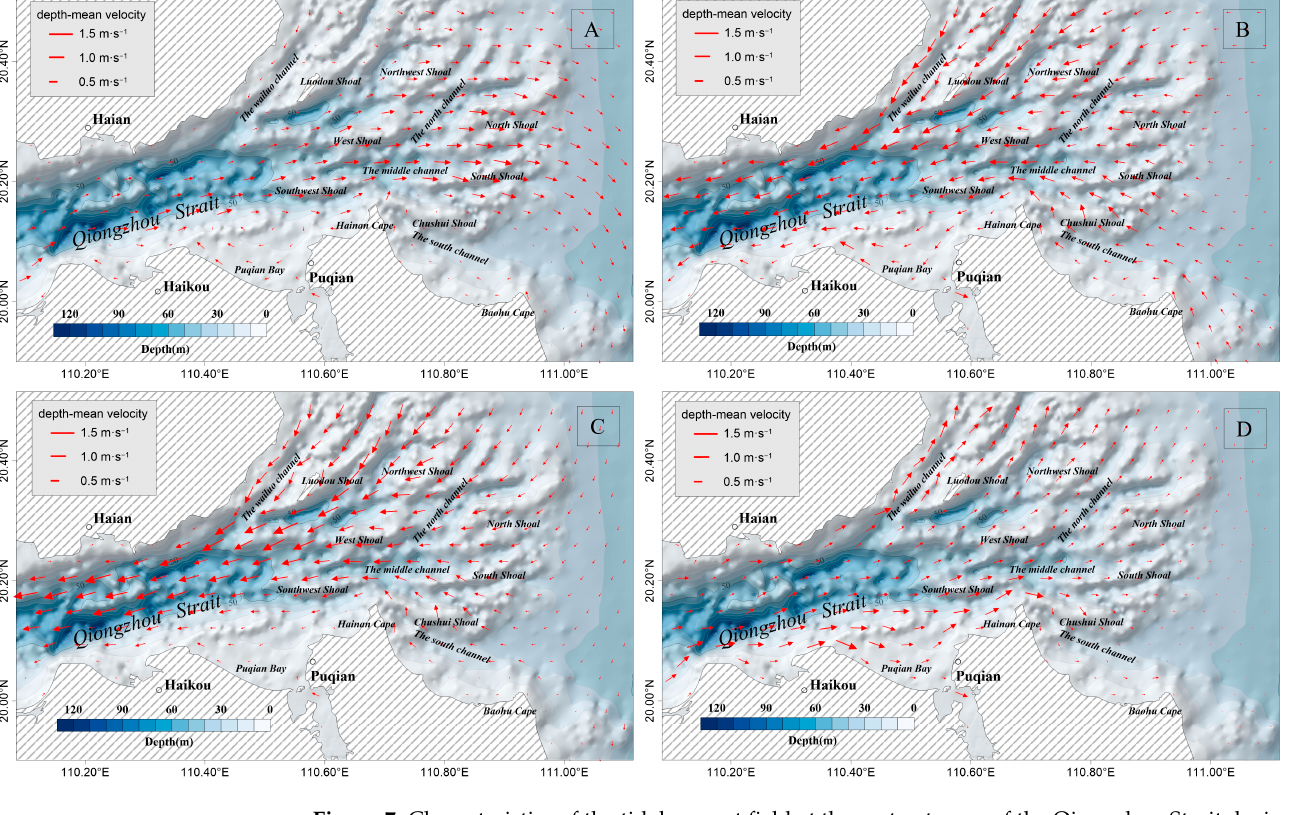
Figure 7. Characteristics of the tidal current field at the east entrance of the Qiongzhou Strait during different tidal phases. ( A ) Eastward ebb current, ( B ) westward flood current, ( C ) westward ebb current, and ( D ) eastward flood current. Table 1. The tidal current velocity in different tide phases at the east entrance of the Qiongzhou Strait. Phase A represents ebb with an eastward current. Phase B represents flood with a westward current. Phase C represents ebb with a westward current. Phase D represents flood with an eastward current. The number before the slash shows the maximum velocity and the number behind the slash shows the average velocity, with unit of m · s − 1 . The number in the bracket shows the distribution proportion of the statistical